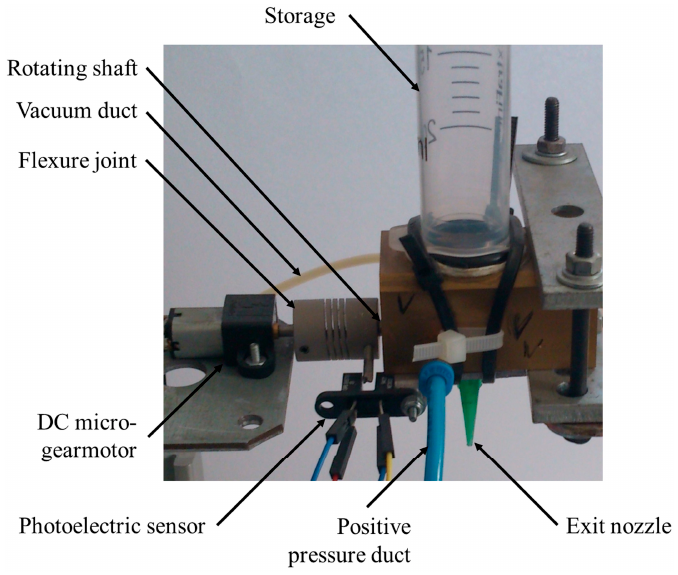
Figure 4. Developed prototype of the singularization mechanism for micro-spheres with diameters of 0.6